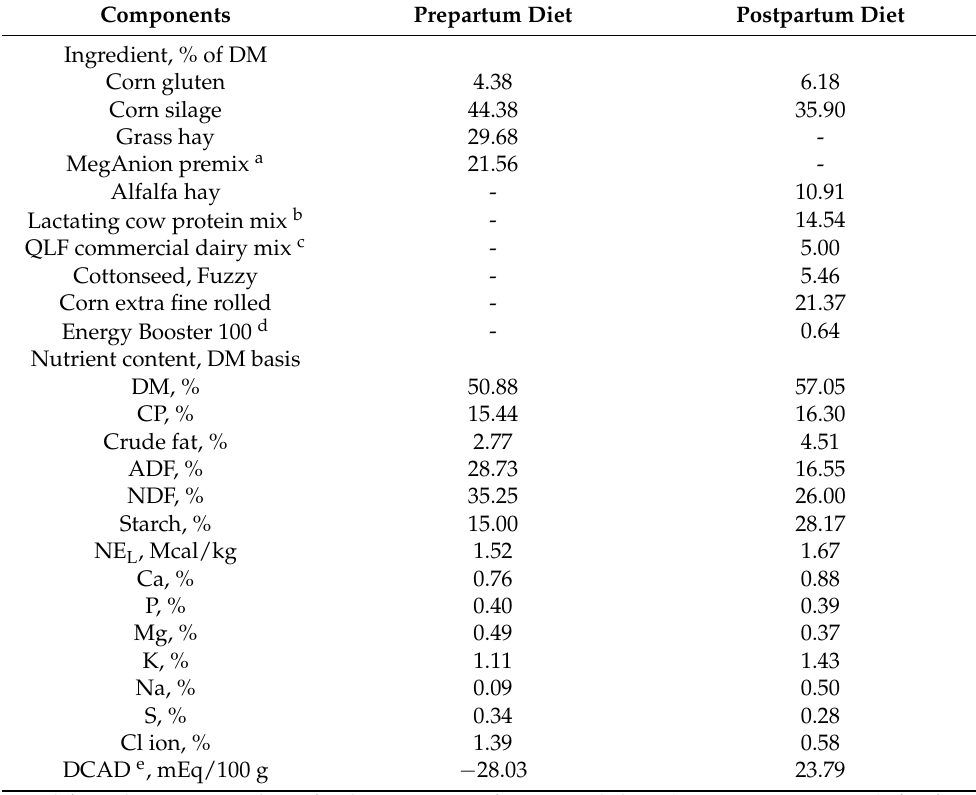
Table 1. Ingredient and nutrient content of diets fed pre- and